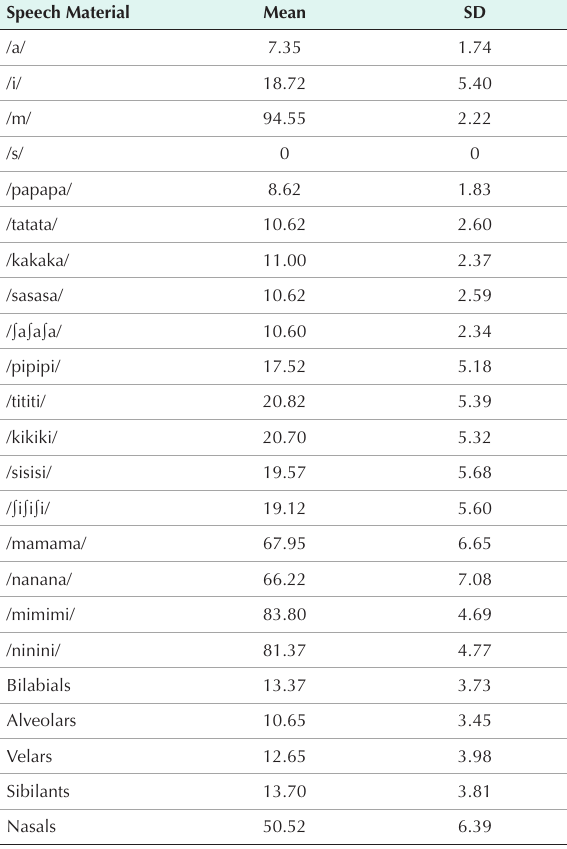
Table 1 . Mean Nasalance Scores (%) and Standard Deviation for Persian- Speaking Girls Aged 4-6 Years